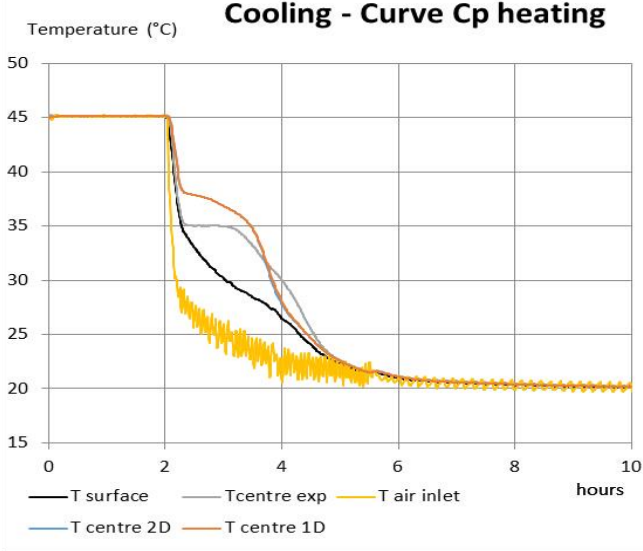
Figure 15. Temperature variation at the centre of the container. Cooling case with the heating c p curve.